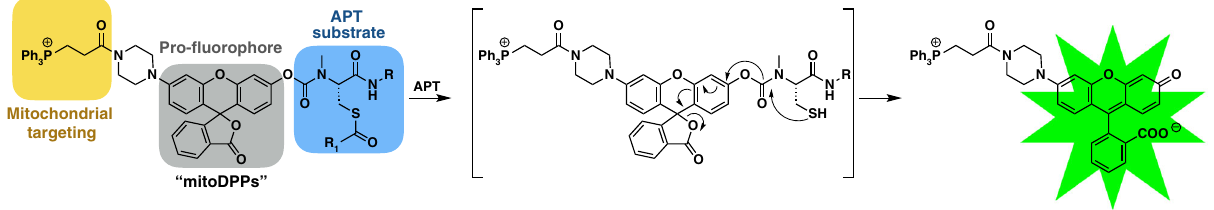
Fig. 1 Design and activation of mitoDPPs. MitoDPPs localize to the mitochondria via an appended triphenylphosphonium group, which delivers the probe to the mitochondria based on the electrochemical potential. The carbamate-linked APT substrate forces the fl uorophore into the lactone-closed, non- fl uorescent form. Cleavage of the thioester by reaction with an APT releases the thiol, which rapidly cleaves the carbamate, generating a fl